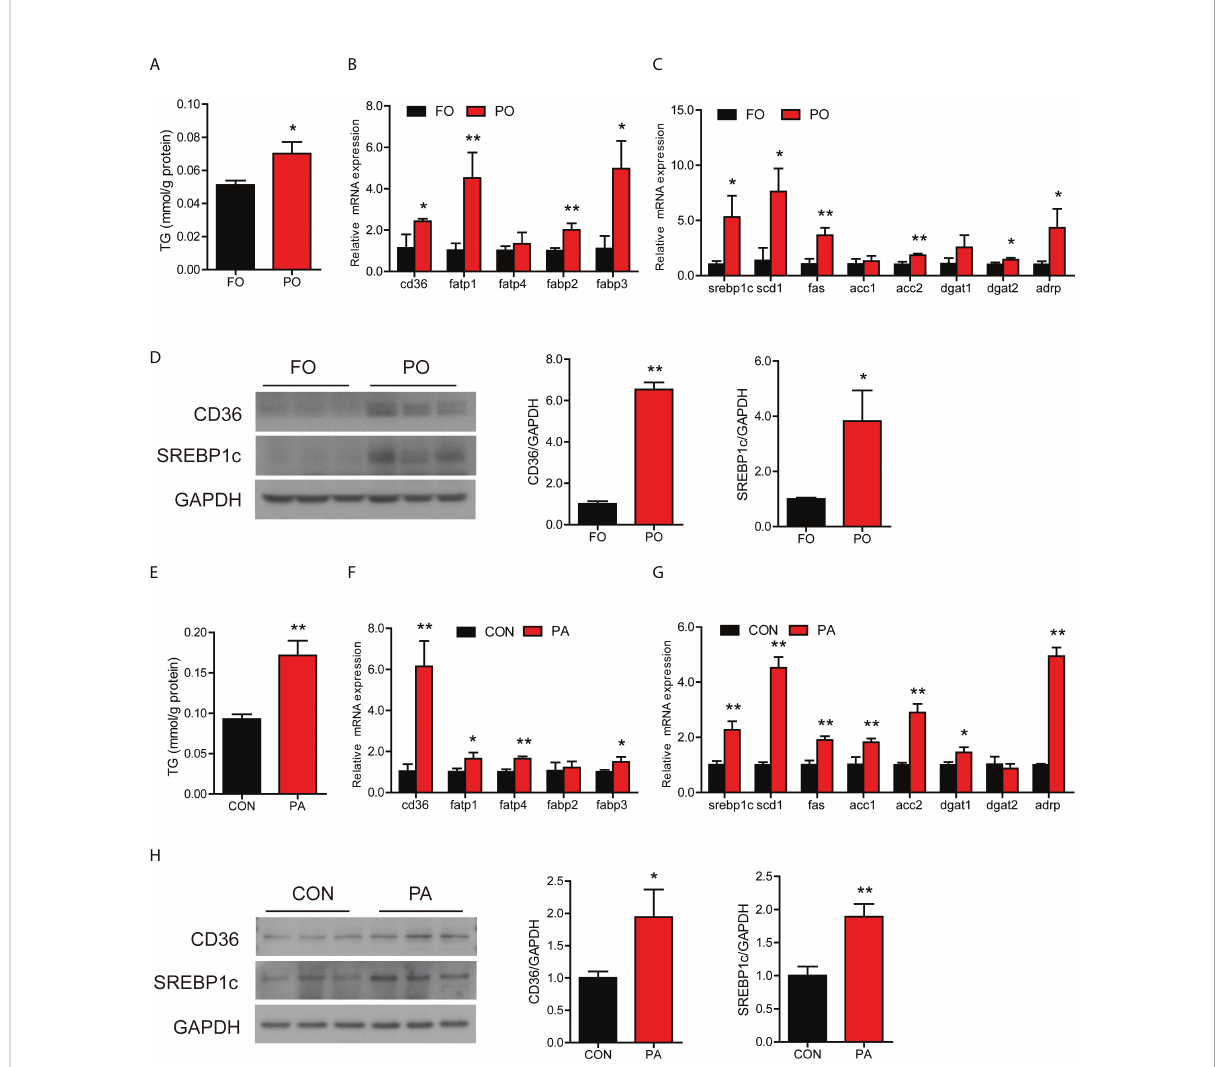
FIGURE 1 Effect of PO or PA treatment on lipid metabolism in the intestine or intestinal cells of large yellow croaker. (A) TG content in the intestine after different diets (n = 3). (B) Fatty acid uptake and (C) lipid synthesis-related genes expression in the intestine after different diets (n = 3). (D) Protein levels of CD36 and cleavage of SREBP1c in the intestine after different diets (n = 3). (E) TG content in the intestinal cells after BSA or PA treatment (n = 3). (F) Fatty acid uptake and (G) lipid synthesis-related genes expression in the intestinal cells after BSA or PA treatment (n = 3). (H) Protein levels of CD36 and cleavage of SREBP1c in the intestinal cells after BSA or PA treatment (n = 3). Results were presented as mean ± standard deviation (SD) and analyzed using independent t -test (* P < 0.05, ** P < 0.01). FO, fi sh oil; PO, palm oil; CON, bovine serum albumin treatment; PA, palmitic acid